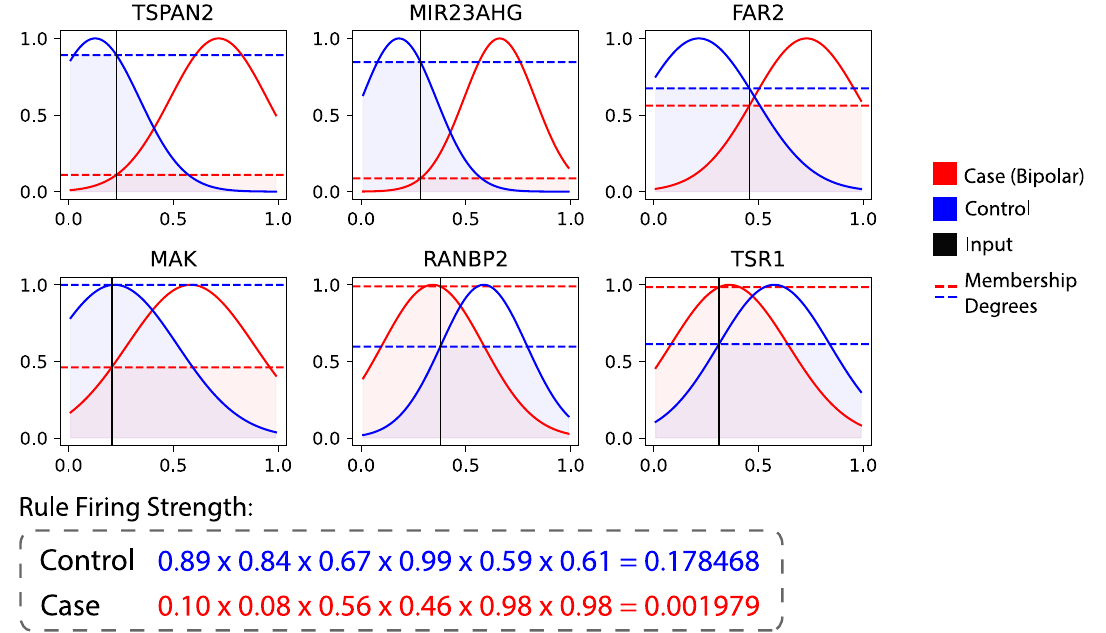
Figure 5. Visualisation of personalised rule profile from a random selected sample (individual) in the bipolar data. Each plot shows the genes and the associated membership functions. The colours red and blue distinguish between the two rules representing case and control respectively. The black vertical lines represent the observed gene expression values of the individual. The horizontal lines represent the degrees of membership of each input with respect to the antecedents and the associated fuzzy sets. The individual is correctly classified by the proposed PCNFI in the class of Control (in blue). LYRIKS dataset BP dataset Gene Frequency